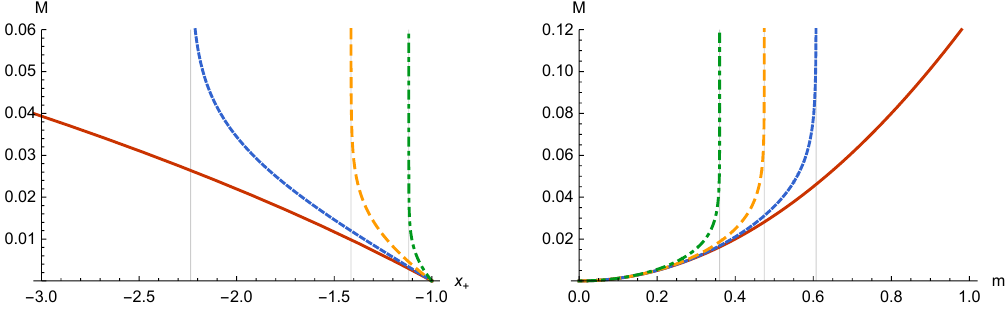
Figure 19 . The holographic mass M of the BTZ black-hole pulled by a wall at various acceleration parameters: A = 0 (solid red), A = 0 . 5 ‘ − 1 (dotted blue), A = ‘ − 1 (dashed orange), A = 2 ‘ − 1 (dot-dashed